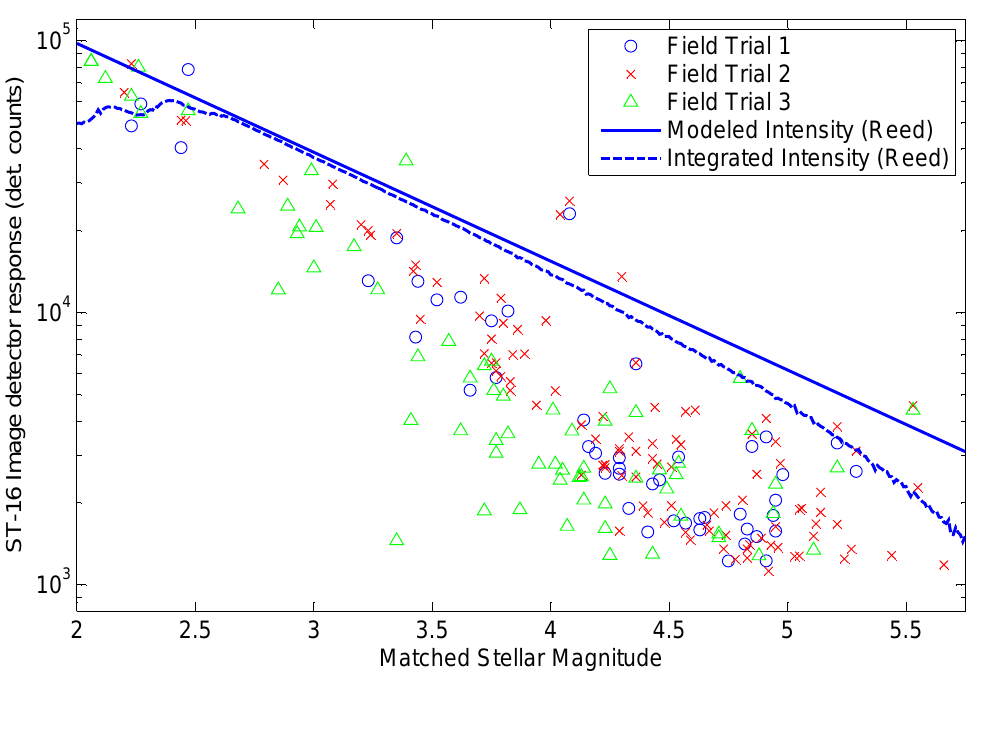
Figure 13. A comparison of star intensity measurements from different field